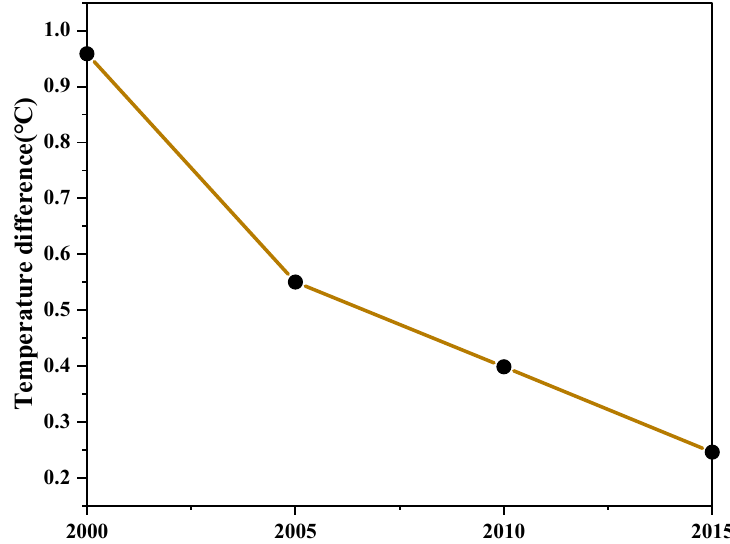
Figure 3. Temperature difference between central and expanded areas in 2000, 2005, 2010, and 2015, with values of 2000, 2005, 2010, and 2015 is 0.96, 0.55, 0.40, and 0.25 °C, respectively.